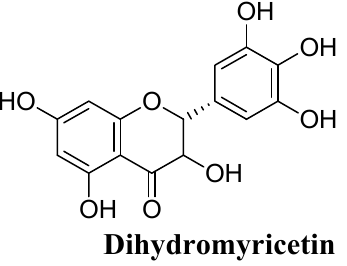
Figure 40. Dihydromyricetin.